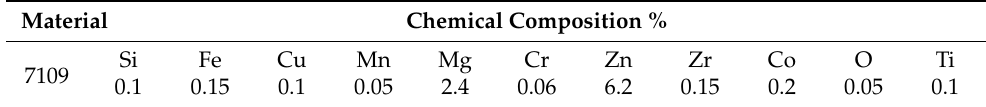
Table 1. Chemical compositions of material of the cutting workpiece.